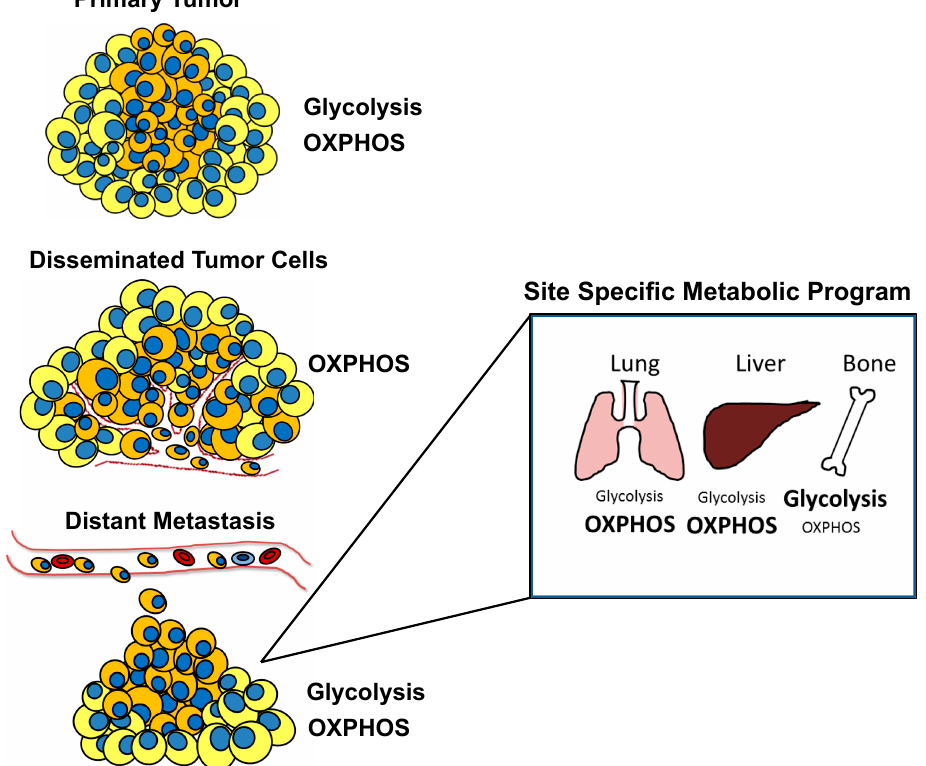
Figure 3. Metabolic plasticity of cancer cells during metastatic cascade. Cancer cells may adopt different energy pathways, i.e., glycolysis or OXPHOS based on their stage in the metastatic cascade as well as the site to which they metastasize.